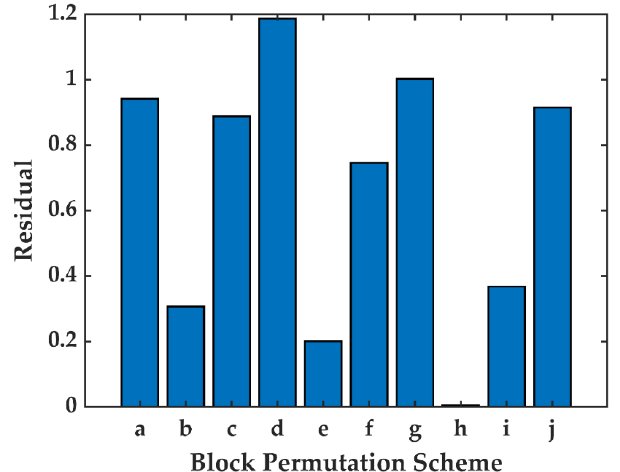
Figure 6. Residuals of face images involving sunglasses with different permutations [authors’ own